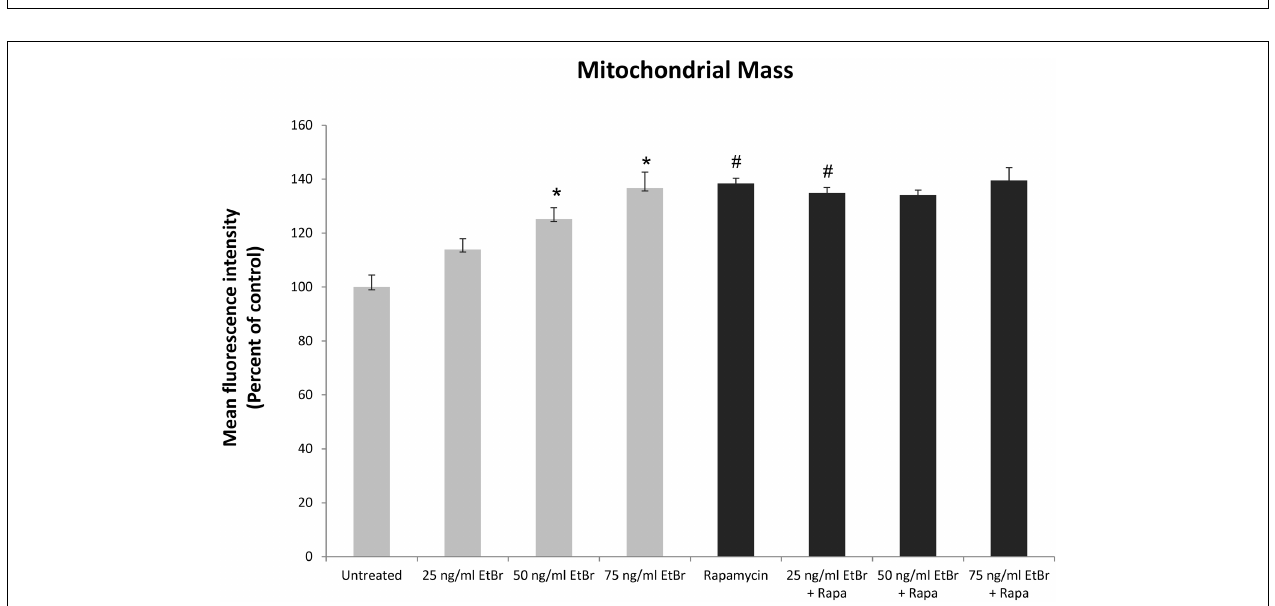
bromide is indicated beneath each bar. Differences between cultures exposed to ethidium bromide and unexposed cultures, which are significant at P < 0.05 are indicated by an asterisk and differences between control and rapamycin treated cultures under identical conditions are indicated by a pound sign.The graph contains a representative experiment of a minimum of two independent replicates with similar results and significance.